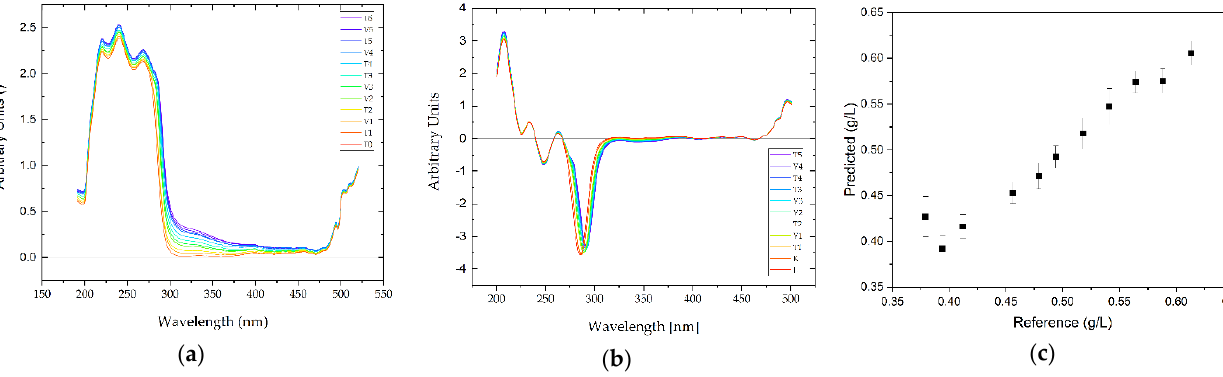
Figure 23. DAD raw ( a ) and processed spectra ( b ) as well as titer prediction vs. reference ( c ) after alkaline lysis and